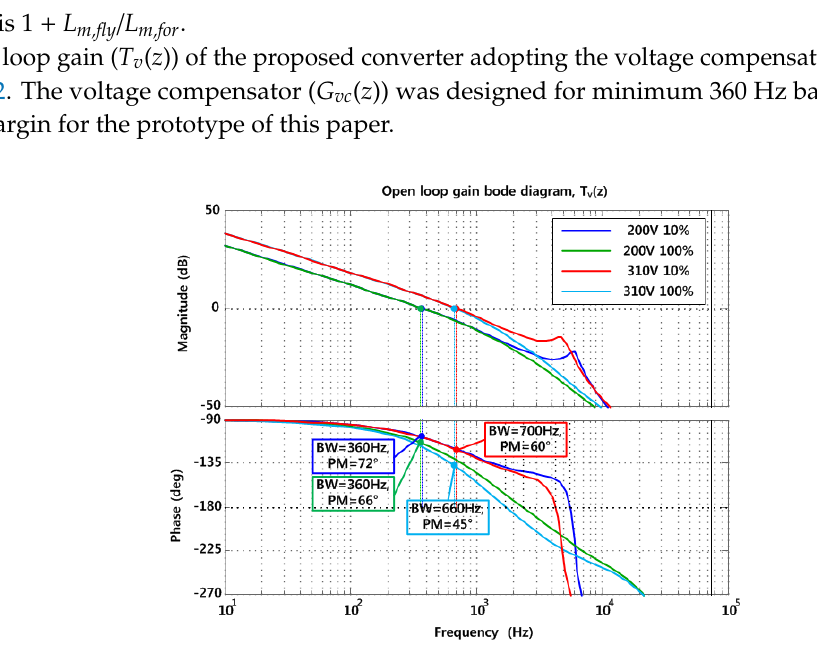
Figure 12. Loop gain of the proposed converter with voltage compensator.